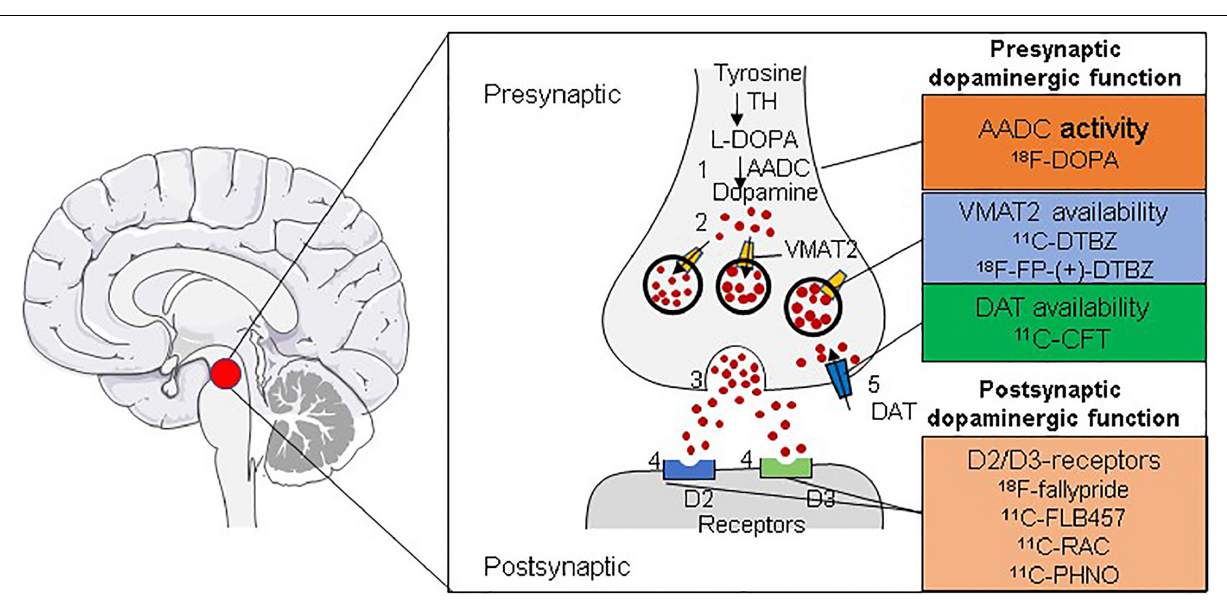
FIGURE 2 | Radiotracers for imaging the dopaminergic system. Shown are the radiotracers used for the in vivo imaging of the dopaminergic system for the diagnosis of PD. Tracers can be used for imaging either presynaptic (AADC, VMAT2, or DAT) or post-synaptic (D2/D3 receptors) dopaminergic function through positron–emission tomography